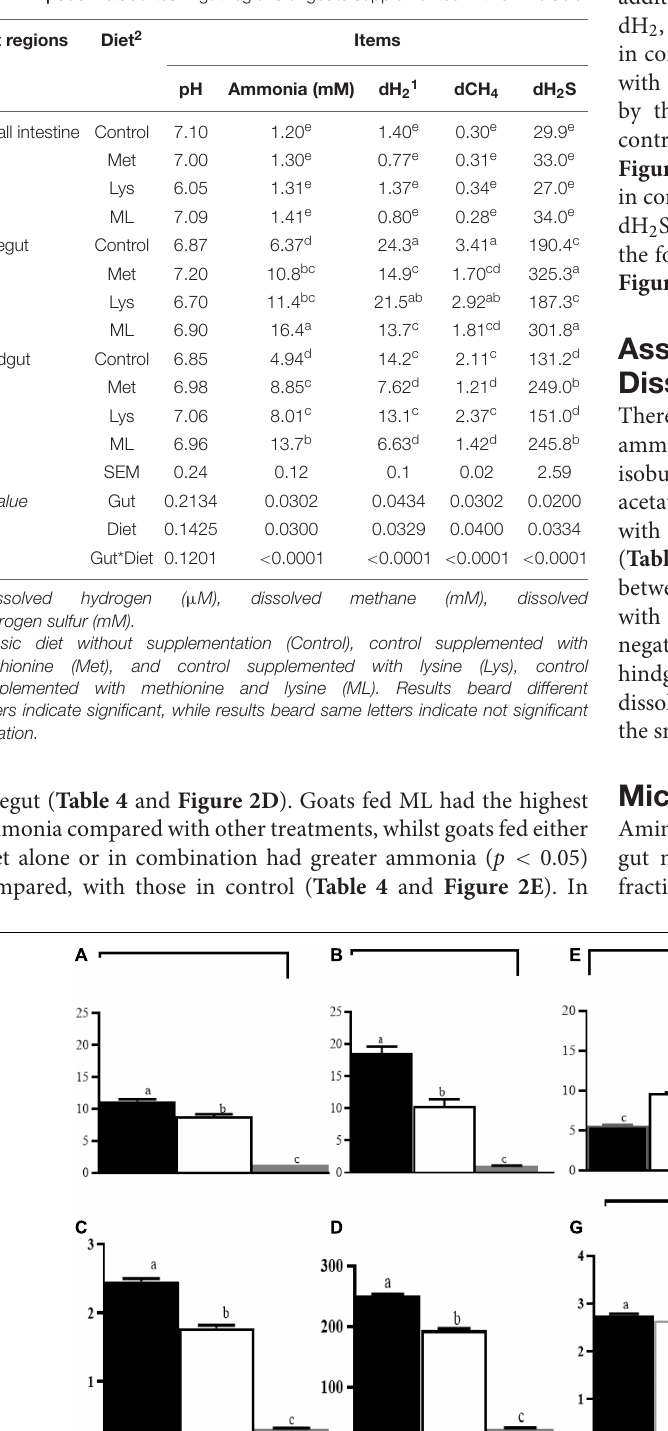
TABLE 4 | Gas metabolites in gut regions of goats supplemented with amino acid.